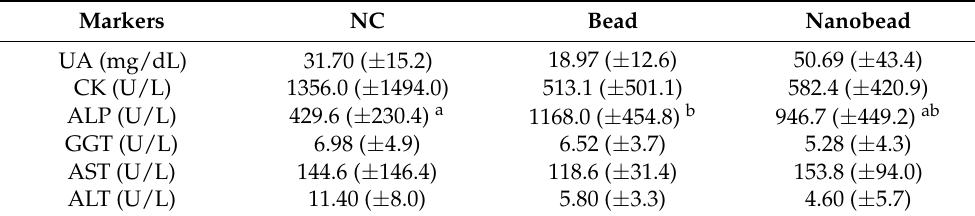
Table 6. Biochemical markers indexes in the CE serum treated with different groups. Data are provided as median ± SEM, n = 12. One-way ANOVA/Tukey tests were performed for the analyses of intergroup differences among each marker. a,b = ( p < 0.05). Markers NC Bead Nanobead UA (mg/dL) 31.70 ( ± 15.2) CK (U/L) 1356.0 ( ±